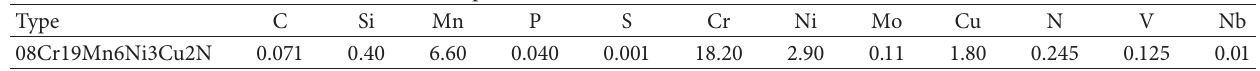
Table 1: Chemical compositions of base metal and filler metal (mass fraction, %).